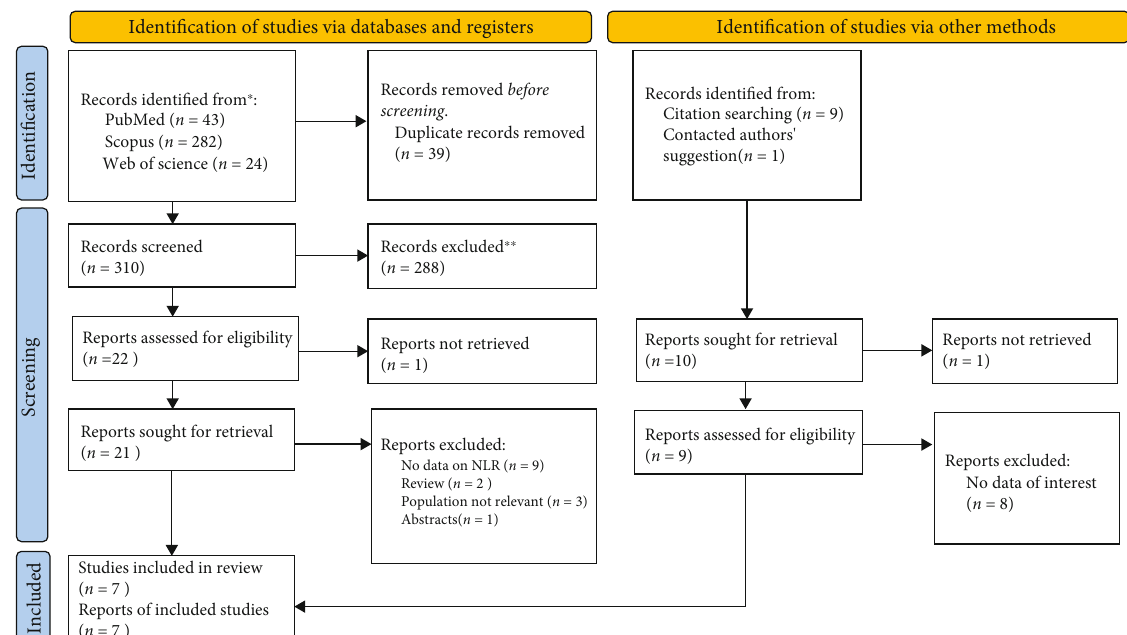
Figure 1: PRISMA 2020 fl ow diagram for new systematic reviews which includes searches of databases, registers, and other